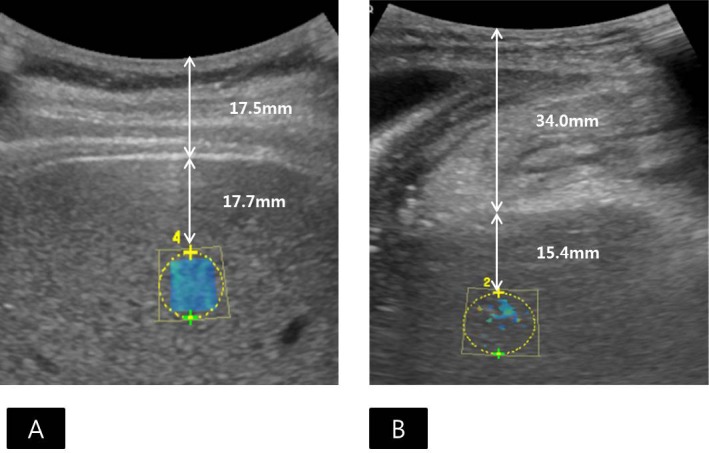
Applicability of 2D comb-push shear wave elastography (SWE) measurements.(A) Applicable SWE examination with technical success and reliable measurement in a 43-year-old male liver donor with a body mass index (BMI) of 25.73 kg/m2. The region of interest (ROI) was placed in the right upper lobe, avoiding large vessels and areas with artifacts, and 17.7mm away from the Glisson capsule. Sufficient color maps covering more than 50% of the sampling area for all acquisitions were obtained, which was regarded as a technical success. The interquartile range/median ratio was 6.51%, which was lower than 30% and was considered as a reliable measurement. The median liver stiffness (LS) value was 4.15kPa, and the histologic fibrosis was proven to be stage F0. Note that the distance between the transducer and Glisson capsule was 17.5mm. (B) Non-applicable SWE examination with technical failure in a 68-year-old female patient with a BMI of 21.26kg/m2,who was awaiting liver transplantation. The ROI was placed in the right upper lobe, devoid of large vessels and areas of artifacts, and 15.4mm away from the Glisson capsule. Despite 12 trials, color filling of the elastography map was insufficient, which was regarded as a technical failure. Note that this was the only case of technical failure in our study, and the distance between the transducer and Glisson capsule was 34.0mm.